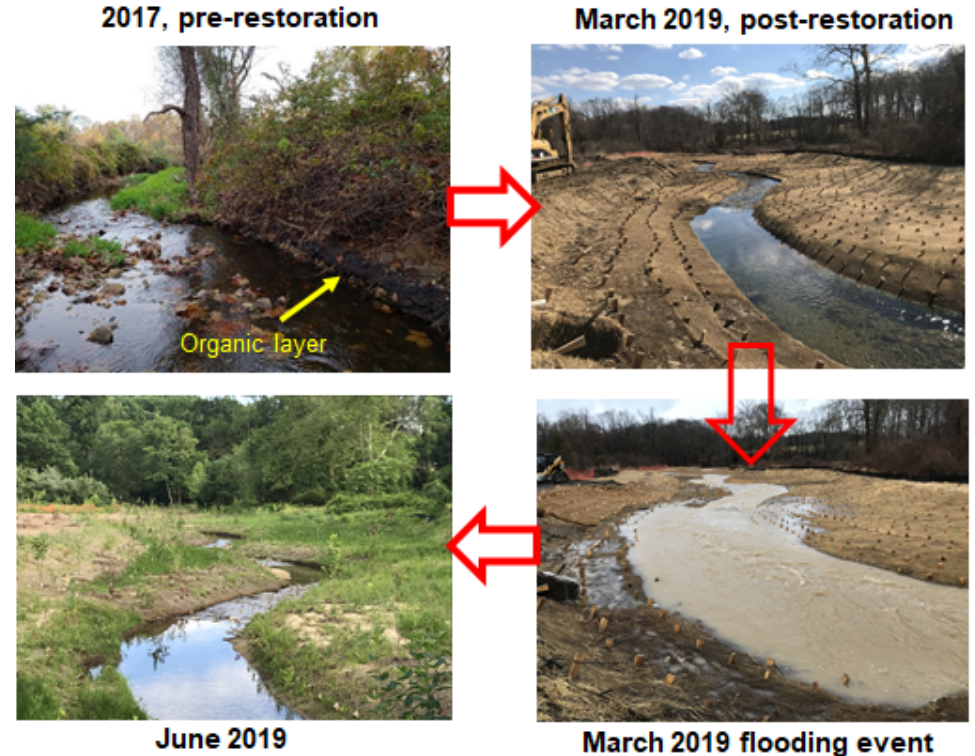
Figure 4. Sequence of photos for a reach in Phase II indicating the progression of restoration at Gramies Run. Note the pre-restoration height of the near-vertical stream banks and the location of the precolonial organic layer (top, left; photo by Brian Tetrick) and the new wider floodplains which allowed bank overflows during storms (bottom right).